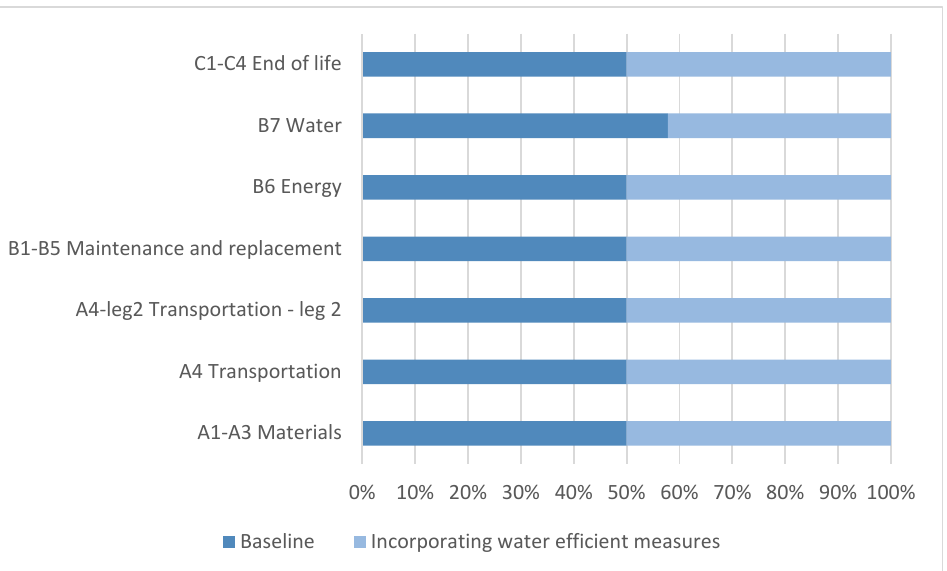
Figure 10. Comparison between baseline and incorporation of water saving measures.